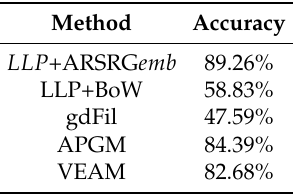
Table 7. Recognition accuracy on the ETH-80 database.